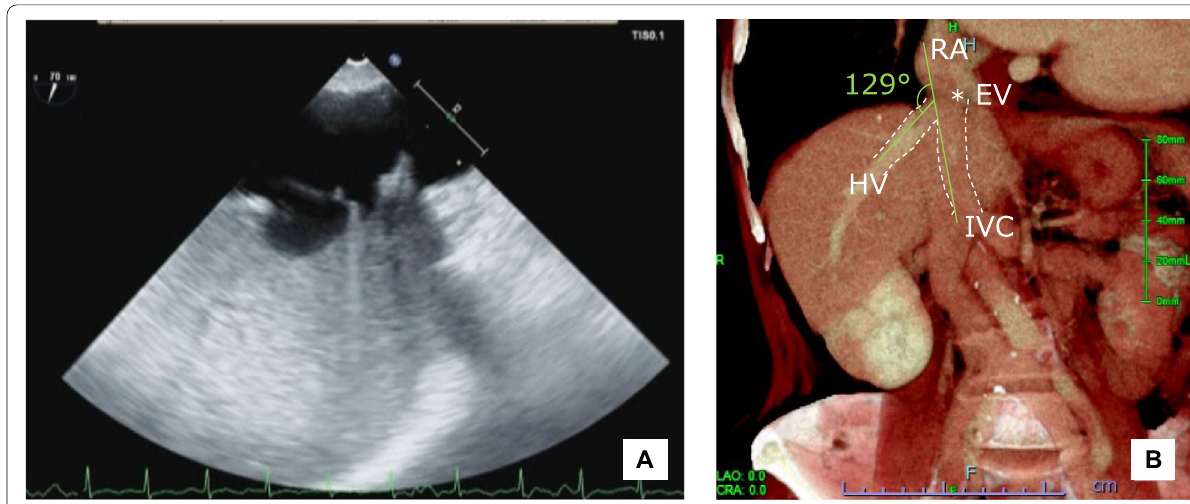
Fig. 1 Echocardiographic and CT images in case 1 showing a strayed guidewire that was inserted from the FV to the HV. A TEE image of the IVC and HV junction. The GW was obstructed by the EV and strayed into the HV. B Coronal CT image of the junction of the HV and the IVC. The angle between the IVC and the HV is 129°, which is an obtuse angle. A low-absorption density indicating the Eustachian valve is seen on the right atrial side of the junction between the HV and the IVC. CT, computed tomography; FV, femoral vein; TEE, transesophageal echocardiography; ▼ GW, guidewire; IVC, inferior vena cava; EV*, Eustachian valve; RA, right atrium; HV, hepatic